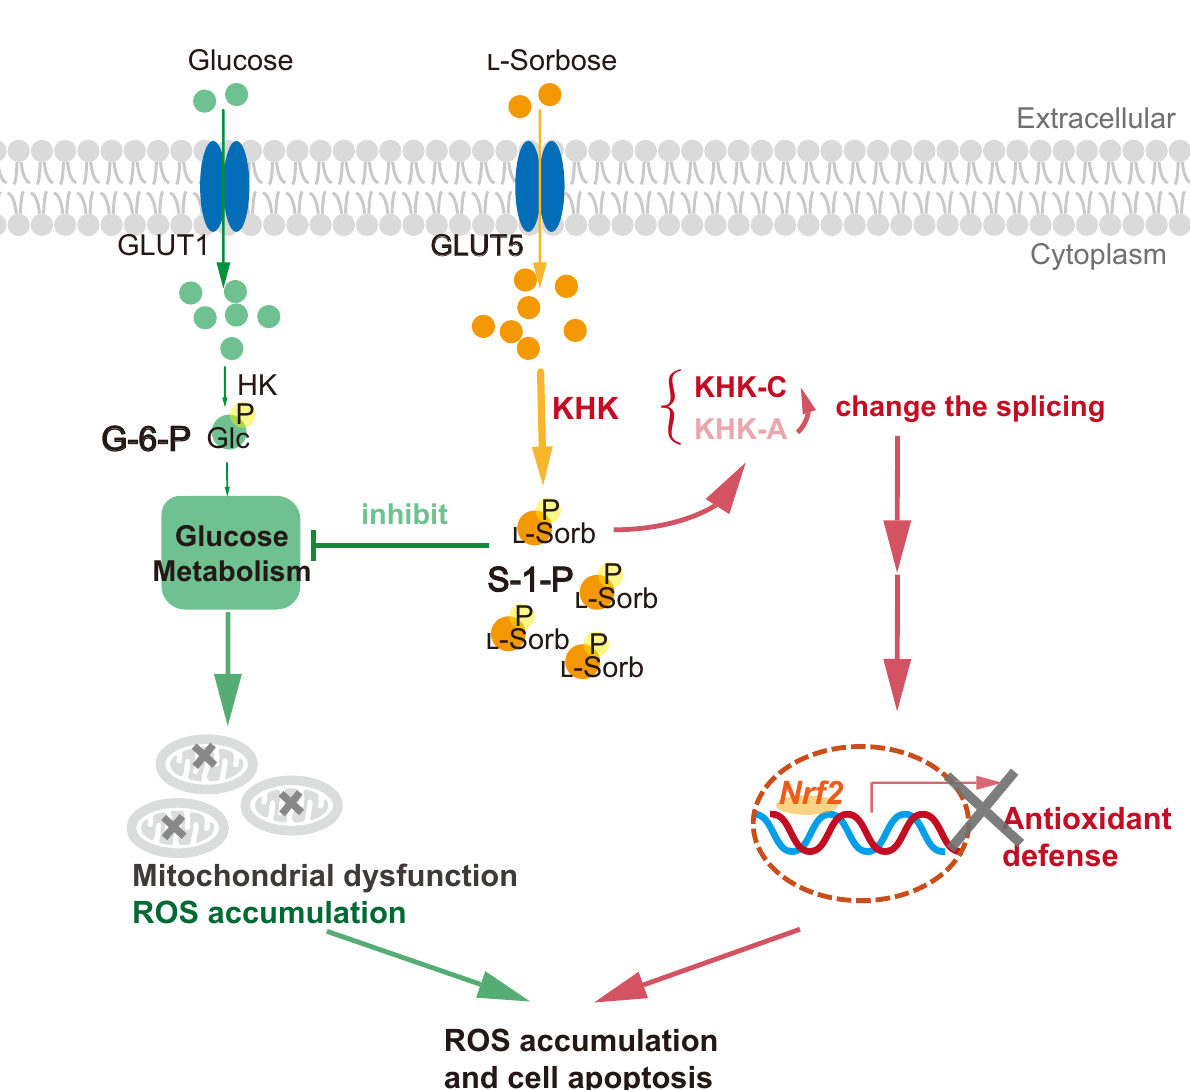
Fig. 9 Model of the antitumor mechanism of L -sorbose. L -Sorbose enters cells primarily through GLUT5 and is then converted to L -sorbose-1-phosphate (S-1-P) by KHK. S-1-P inhibits the activity of HK, which induces mitochondrial ROS production and apoptotic cell death. Furthermore, S-1-P downregulates the expression of KHK-A by modulating the splicing mechanism, which results in attenuation of the Nrf2 antioxidation Thin-layer chromatography (TLC) analysis . The samples were spotted at the bottom of the plate (~1.5cm above the edge), and the TLC plates (Merck, 1057350001) were developed in a vertical developing chamber with the developing centrations were added to the incubation mixture described above to investigate the agent glacial acetic acid:isopropanol:water = 2:2:1. After development, the spots inhibitory effects. were detected by spraying 5% anisaldehyde solution and heat to color development. Statistics and reproducibility . GraphPad Prism8 was used for statistical analysis. In vitro enzyme inhibition assay . Hexokinase activity was assayed through a At least three independent or parallel experiments were performed for statistical coupled reaction with glucose-6-phosphate dehydrogenase (G6PDH) followed by analysis. Data were analyzed by the unpaired Student ’ s t test, one-way ANOVA NADP + detected at 340 nm. Brie fl y, 10 μ L recombinant HK2 (1 μ M) and 10 μ L with Dunnett ’ s test, or two-way ANOVA with Dunnett ’ s test. Three levels of S-1-P were incubated together at 37 °C for 10min. Then 80 μ L assay mix